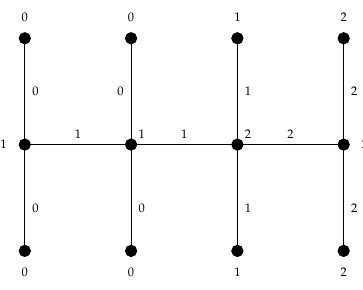
Figure 11. 3-TEMC labeling of DCO